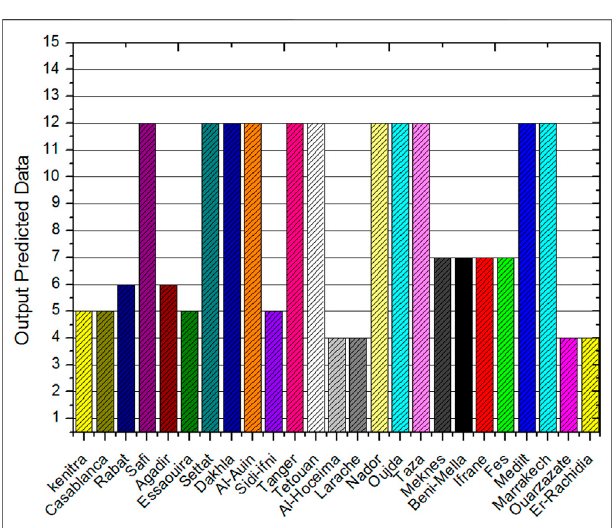
FIGURE9 | Output predicteddata and thebest selected parameters for all Moroccan